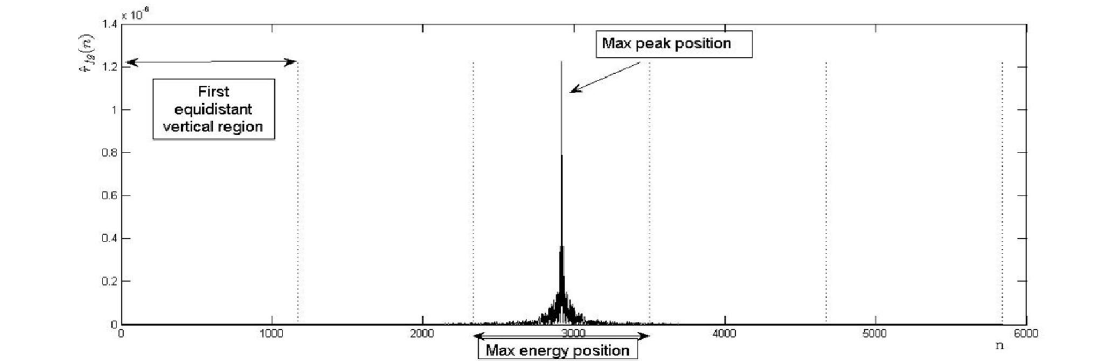
Figure 9. Accepted shape of the BLPOC function through equidistant vertical regions. (iv) Calculate the index of the BLPOC function max peak ( P M ) and determine the equidistant vertical region to which it belongs. (v) Compare the identified region with the acceptance equidistant vertical region. The number of equidistant indices in the experiments was a constant value m = 5 and, on the other hand, the acceptance region was the third equidistant vertical region.